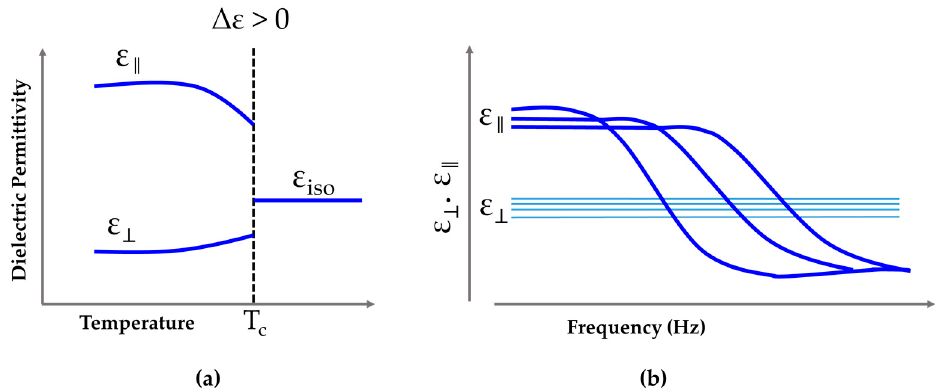
Figure 2. The typical anisotropic behavior of a liquid crystal: ( a ) The temperature dependence of dielectric anisotropy in liquid crystals and ( b ) the frequency dependence of the dielectric constants.